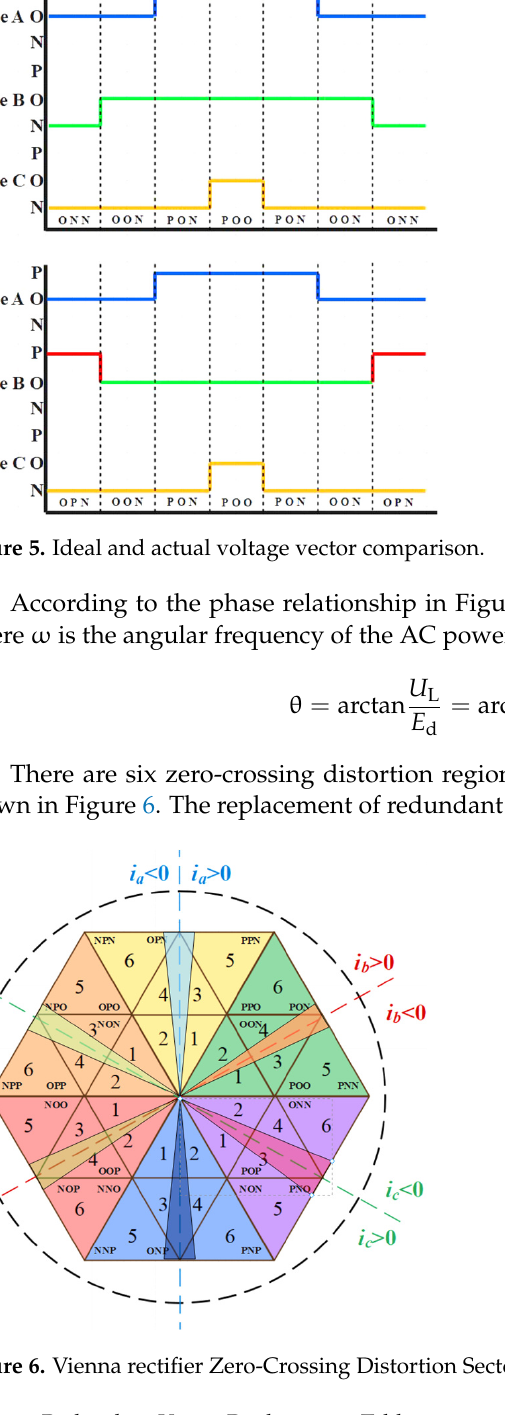
Figure 4. Vector relation of input voltage and current and vector diagram of large sector I space.